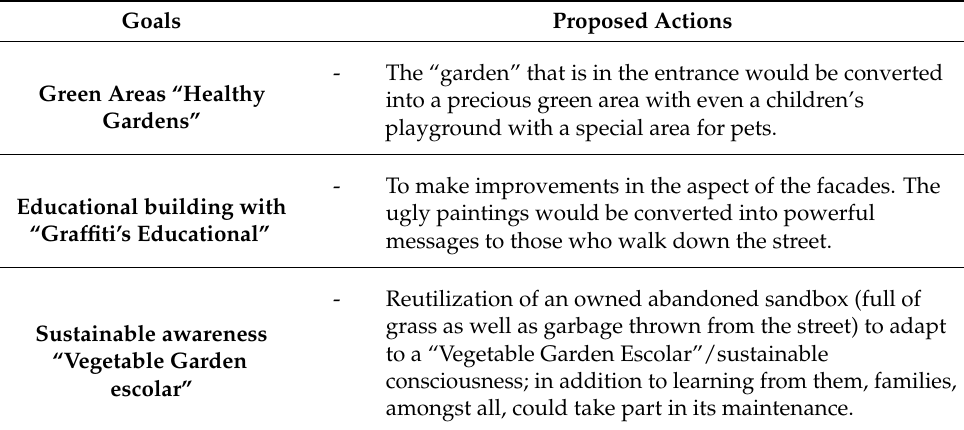
Table 5. Goals of the students’ work “Everyone’s Responsibility: Pet Spreading” by Pio XII Primary